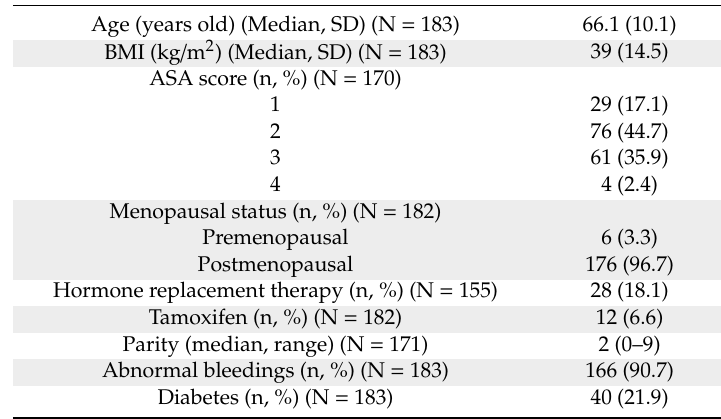
Table 1. Characteristics of population.